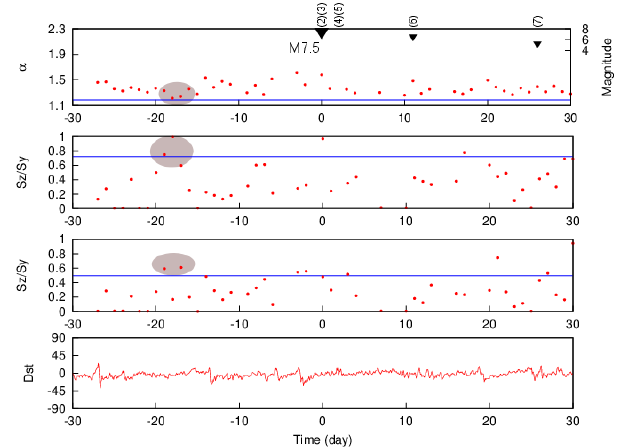
Fig. 8. The temporal variations of the spectral density ratio from 1 September 2008 to 31 October 2010. The first and second pan- els indicate the daily averaged spectral density ratio S z /S y without and with the use of the minimum energy for the frequency range of 0.01 ± 0.003Hz. The bottom panel shows the Dst index. The black triangle indicates the occurrence time of EQs listed in Table 1. The vertical broken line shows the occurrence time of the largest EQ ( M = 7.5). The horizontal blue line in the upper two panels indi- cates mean ± 2 σ for a threshold of anomaly in S z /S y .